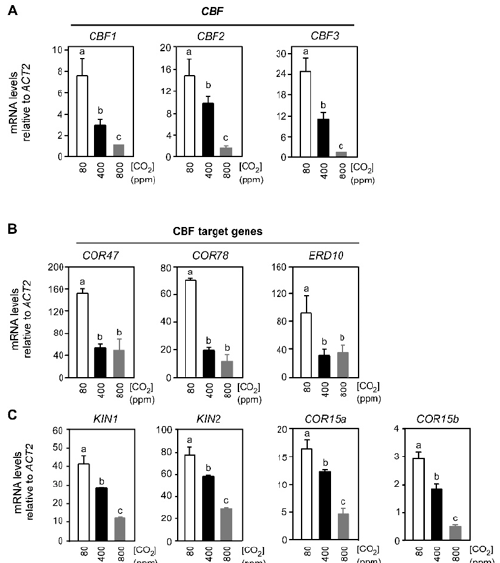
Figure 1. The low temperature expression of CBF and downstream CBF-dependent genes in Arabidopsis is modified by air levels of CO 2 . Individual 3.5 week-old Arabidopsis plants (Col-0) were exposed to 4 °C temperature for 2 h with sub-ambient, ambient, or supra-ambient CO 2 , (80, 400 and 800 μ mol mol − 1 , respectively). Transcript abundance of three CBF genes ( A ), and seven downstream CBF target genes ( B and C ) were determined by q-PCR. The expression of measured transcripts was normalized to ACT2 . Relative values are means (×1000) of three biological replicates and two technical replicates (error bars indicate SEM). Bars labeled with different lowercase letters differed at p ≤ 0.05 and differences were determined using the one-way analysis of variance procedure (ANOVA) and Tukey